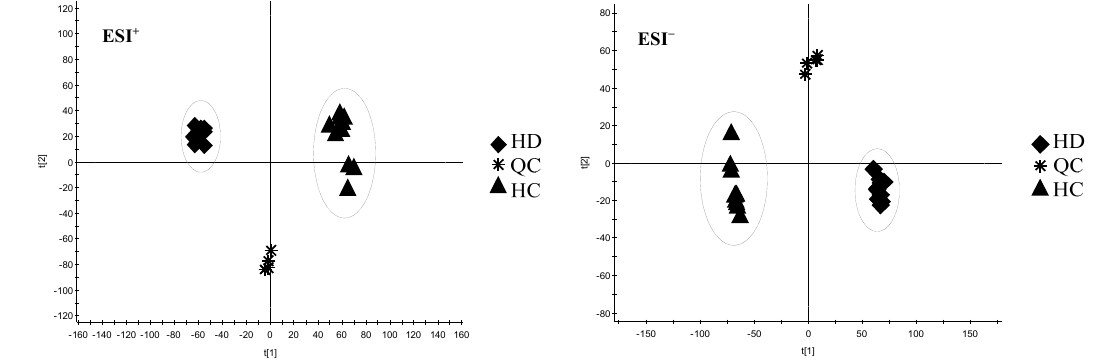
Figure 3. The PCA of HC and HD in positive mode (ESI + ) and negative mode (ESI − ). HD: Hedyotis diffuse Willd. HC: Hedyotis corymbosa (L.) Lam. QC: Quality Control.